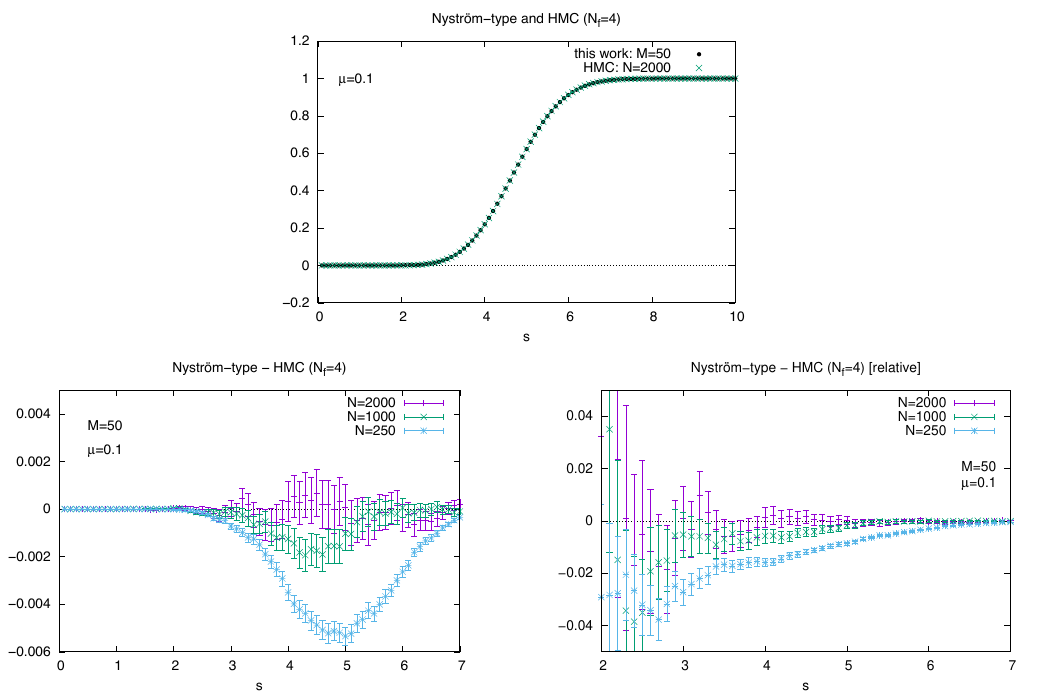
Figure 3 . F 1 ( s ) is computed for the chiral GSE with N F = 4 ( (cid:11) = 1) quadruply-degenerated masses (cid:22) 1 = 0 : 1 and the topological charge (cid:23) = 0 in two ways. In the top panel, the Nystr(cid:127)om-type discretization of order M = 50 is applied (black dot) and the hybrid Monte Carlo simulation is applied with the random rank N = 2000, F HMC ( s ) (green cross). The error of the HMC result, 1 which is not shown in the top panel, is smaller than the symbols. The bottom left panel shows the di(cid:11)erence of these two methods, F 1 ( s ) (cid:0) F HMC ( s ) with N = 250 ; 1000 ; 2000. The computational 1 results of the hybrid Monte Carlo simulation converges to that of the Nystr(cid:127)om-type discretization as N grows. The errors plotted come from the Monte Carlo result. The relative di(cid:11)erence normalized by the Nystr(cid:127)om-type is also plotted in in the bottom right panel. Note that the relative di(cid:11)erence looses its meaning for s . 2 as the Nystr(cid:127)om-type result becomes smaller than the Monte Carlo error. N = F